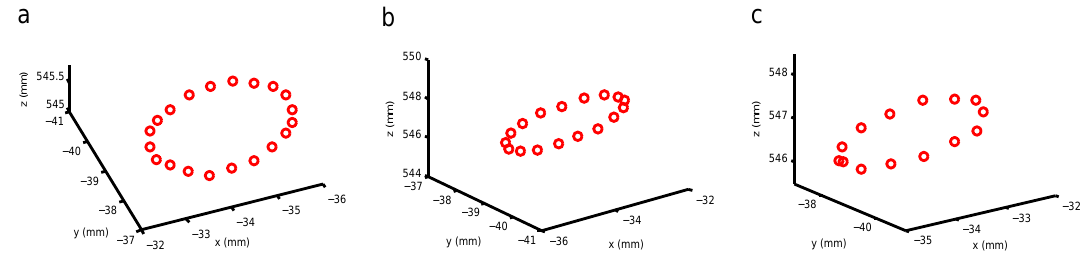
Figure 7. The 3D motion trajectories of feature point at different rotation speed: ( a ) 600 rpm; ( b ) 1200 rpm; and ( c ) 1500